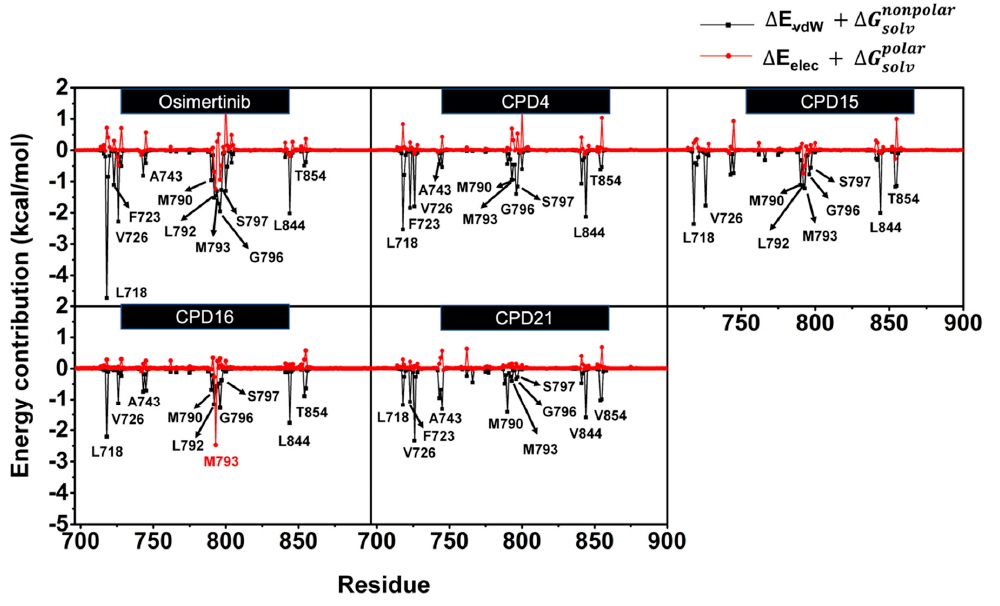
Figure 7. Calculated per-residue vdW ( ∆ E vdW + ∆ G nonpolar ) and electrostatic ( ∆ E elec + ∆ G polar ) decomposition energy to each amino acid largely contributed to ligand